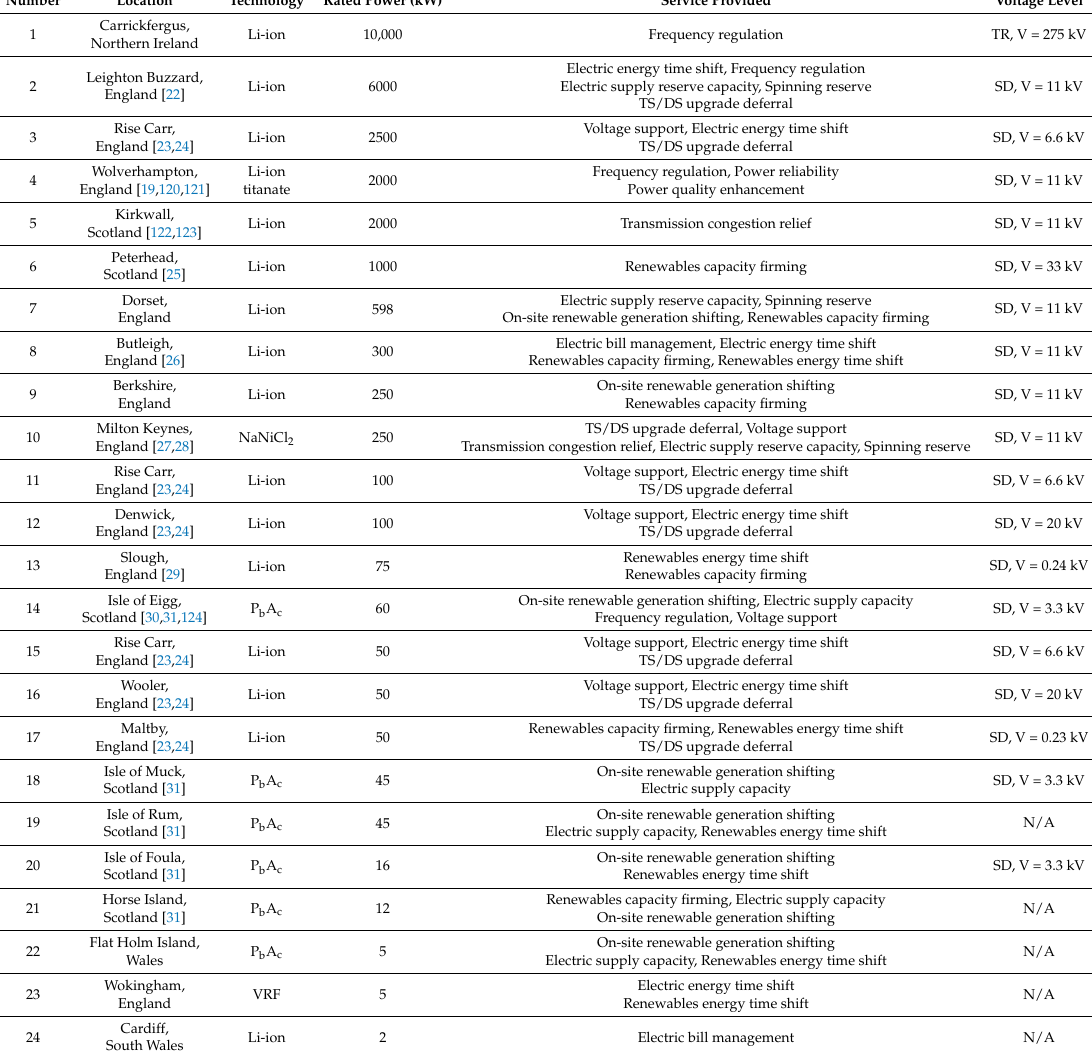
Table A1. Transmission and distribution BESS projects in the